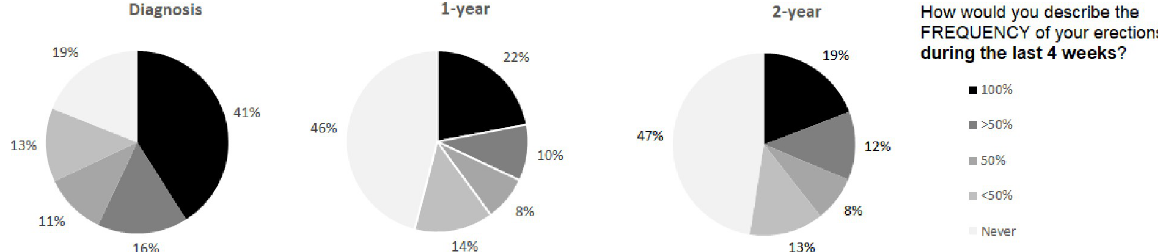
Fig 2. Distribution of the ED answers given by patients at diagnosis, 1-year, and 2-year.